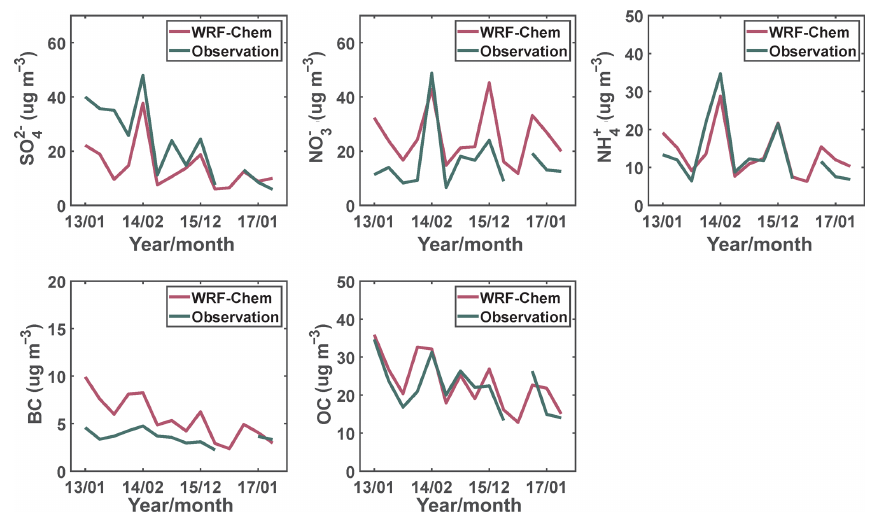
Figure 3. Simulated and observed temporal variations of monthly mean concentrations of PM 2 . 5 chemical components from 2013 to 2017.